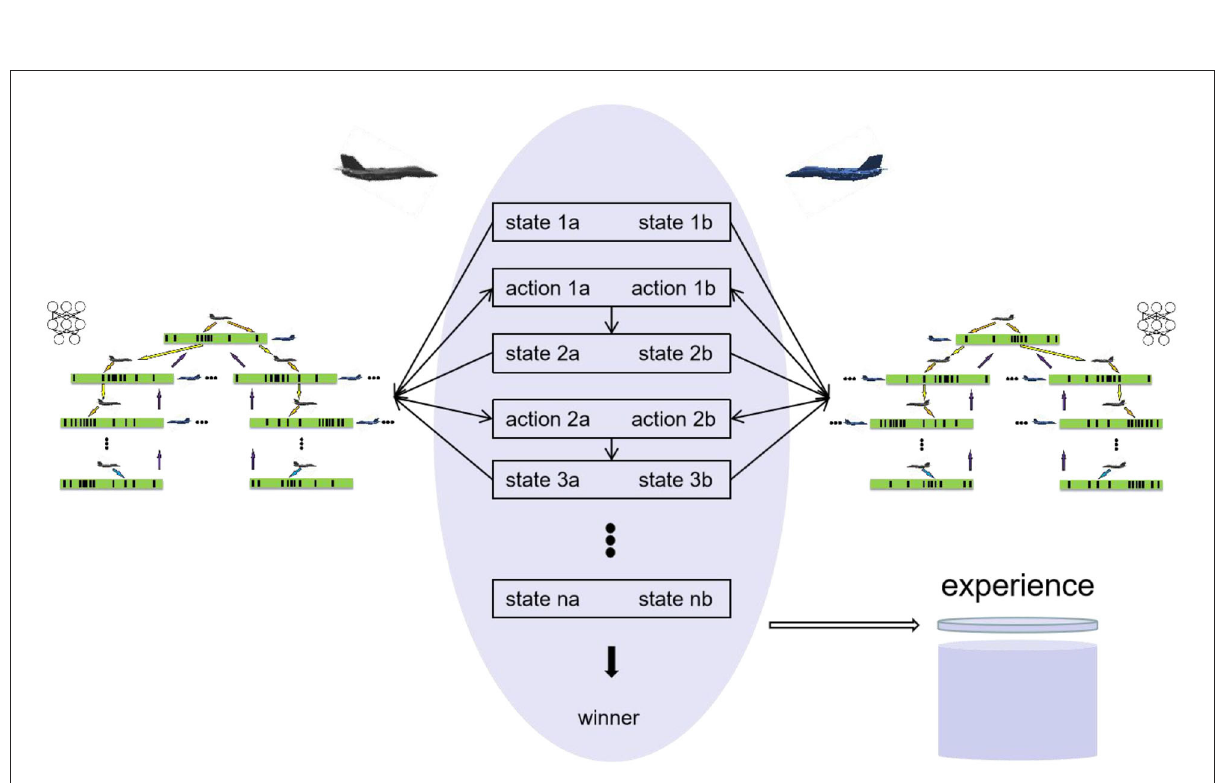
FIGURE3 Air combat